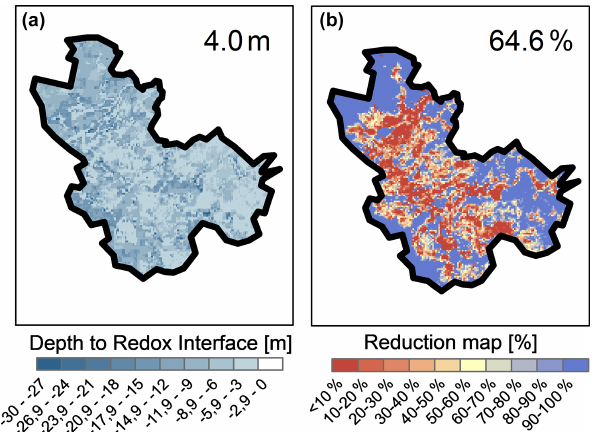
Figure 2. (a) Resulting depth to redox interface after calibration. (b) Nitrate reduction potential maps for the baseline scenario (land use LU0/observed climate) showing the fraction of the leached ni- trate that is reduced for each grid. The number in the upper right corner of each panel is the average across all